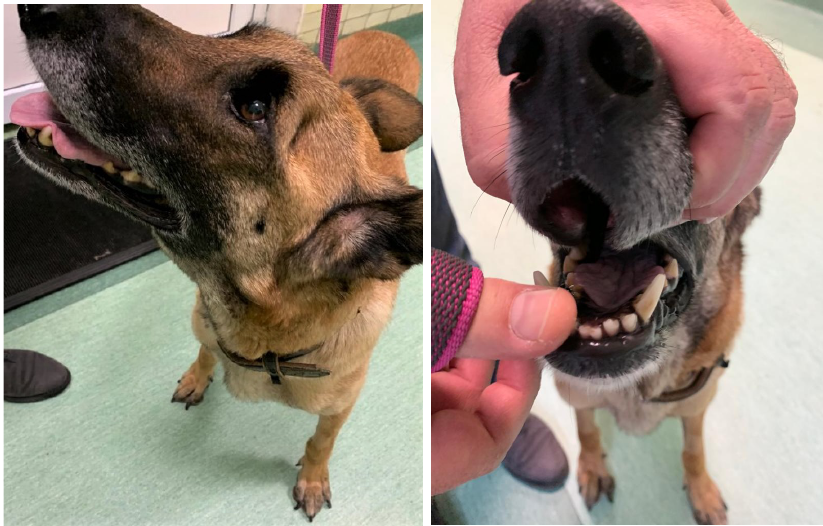
Fig. 1. Muscle atrophy in the temporalis area (Before treatment); Fig. 4. Tongue is wet, thin with crackles. (Original archive)